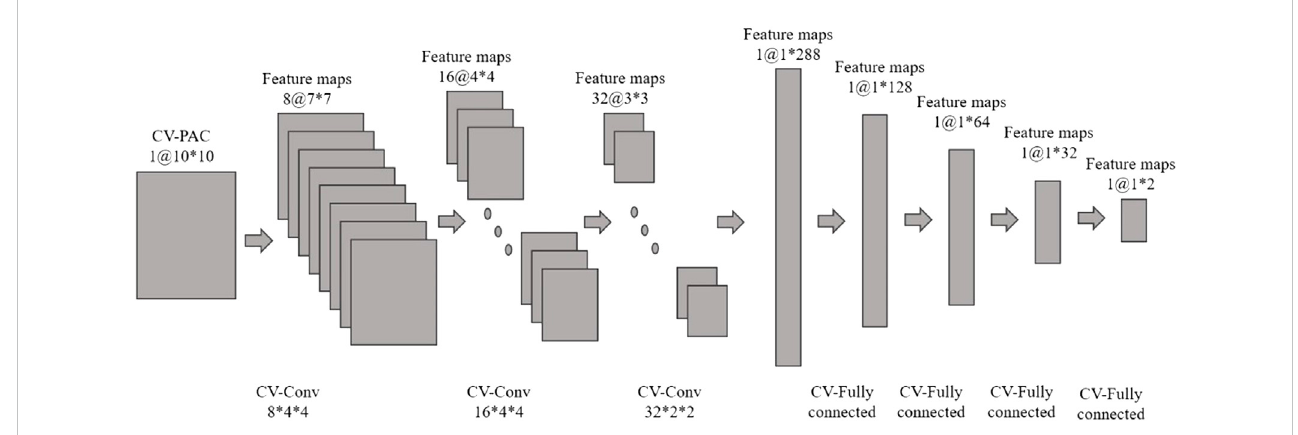
FIGURE 2 Complex-valued convolutional neural network (CV-CNN) with complex-valued phase-amplitude coupling (CV-PAC). There are three complex-valued convolutional layers and four complex-valued fully connected